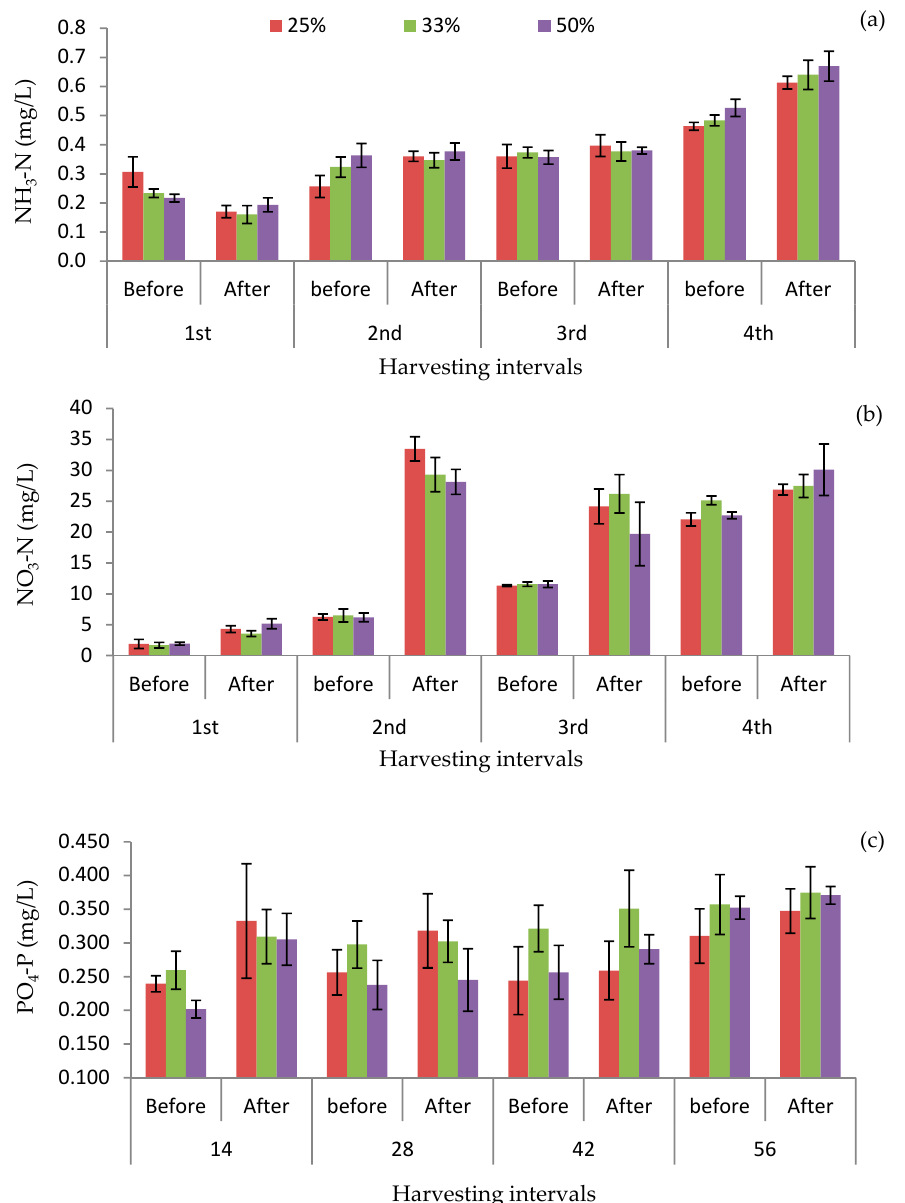
Figure 4. Concentrations of ( a ) ammonia nitrogen; ( b ) nitrate nitrogen, and ( c ) orthophosphate at the outlet of the hydroponic beds before and after two days of harvesting plants (data are the means of three replicates (n = 3), and error bars indicate the standard errors).